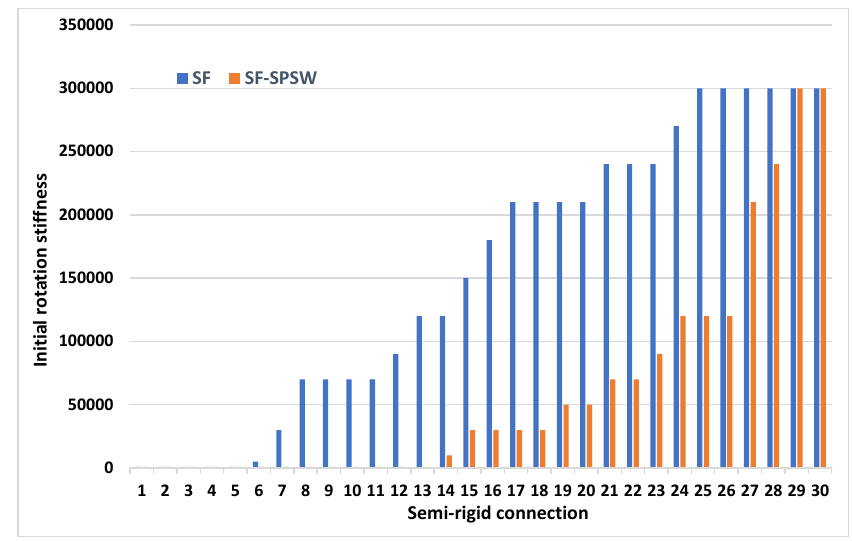
Figure 14. The proportion of the semirigid connections.